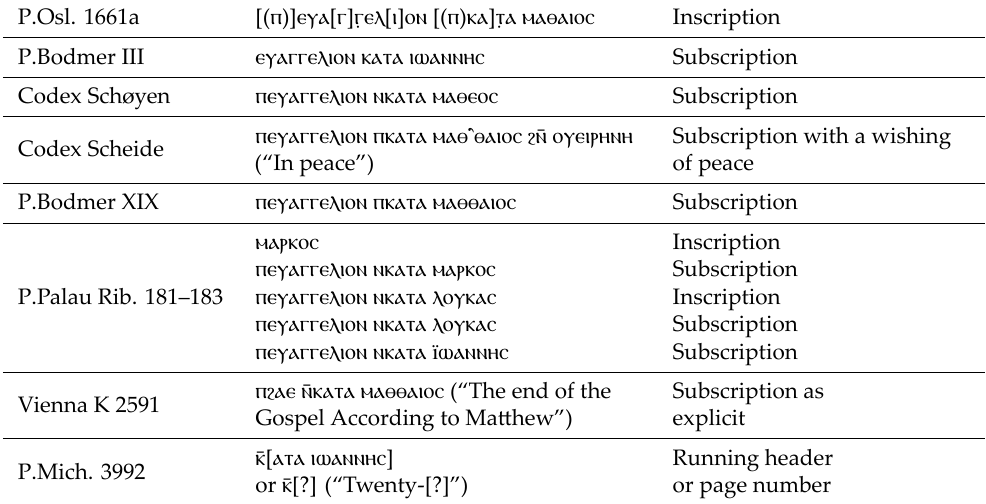
Table 2. Canonical Gospel Titles in Coptic until c. 500